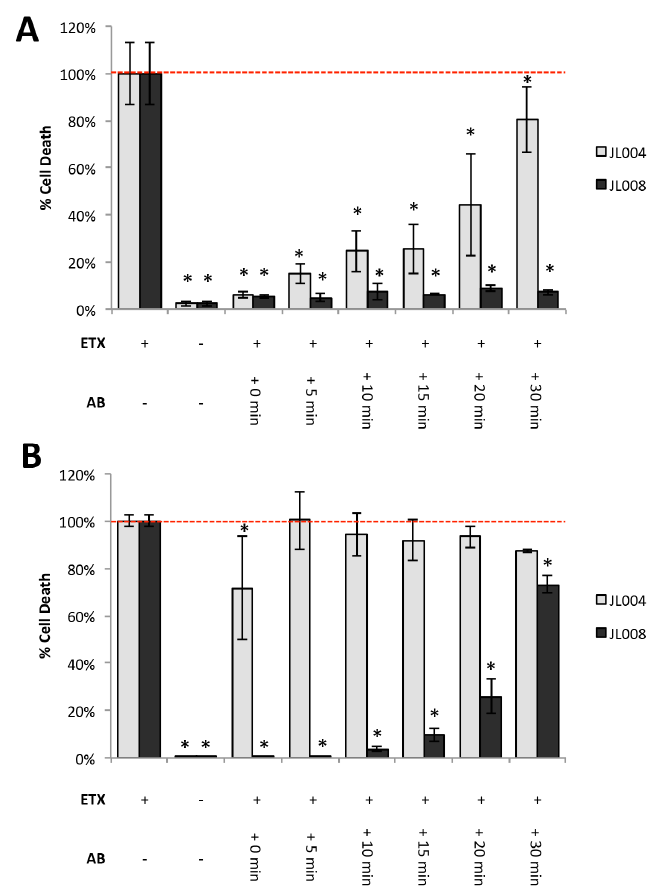
Figure 9. Post-exposure antibody treatment protects against ETX-induced cytotoxicity in vitro. rMAL-CHO cells were treated with 100 nM ETX for four ( A ) or 24 h ( B ). Cells were treated with ETX without antibodies as a positive control. Cells treated without ETX or antibodies were used as a negative control. Anti-ETX antibody JL004 or JL008 were added to cells treated with ETX post treatment at indicated time points; 0, 5, 10, 15, 20, or 30 min. Cell death was determined by PI exclusion. Percent cell death (% Cell Death) was determined by dividing the number of PI+ cells in experimental conditions by the number of PI+ cells when cells were treated with ETX alone. * p < 0.01 compared to ETX-treated controls determined by ANOVA with post-hoc Tukey HSD.